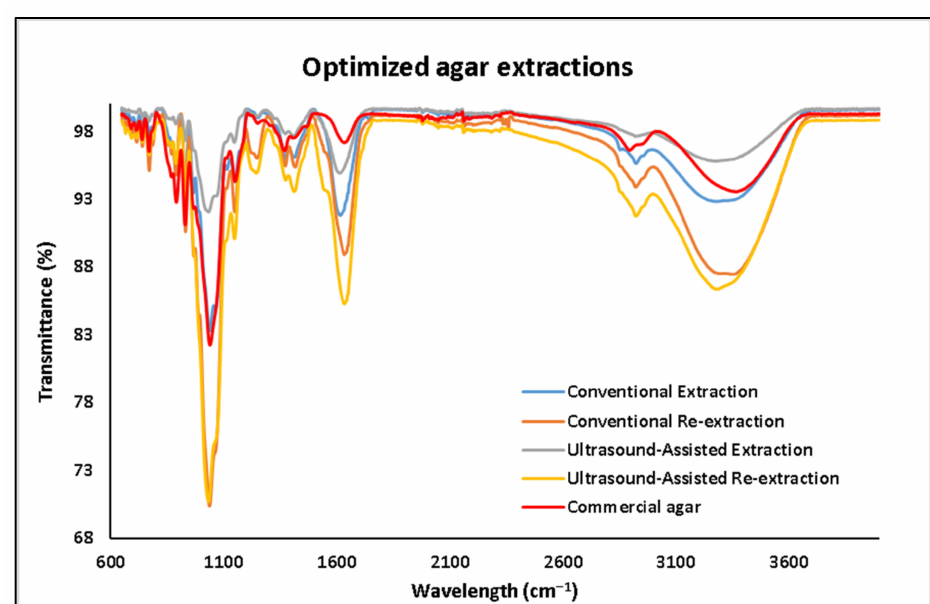
Figure 6. FT-IR spectra of the agar extracted by different optimized